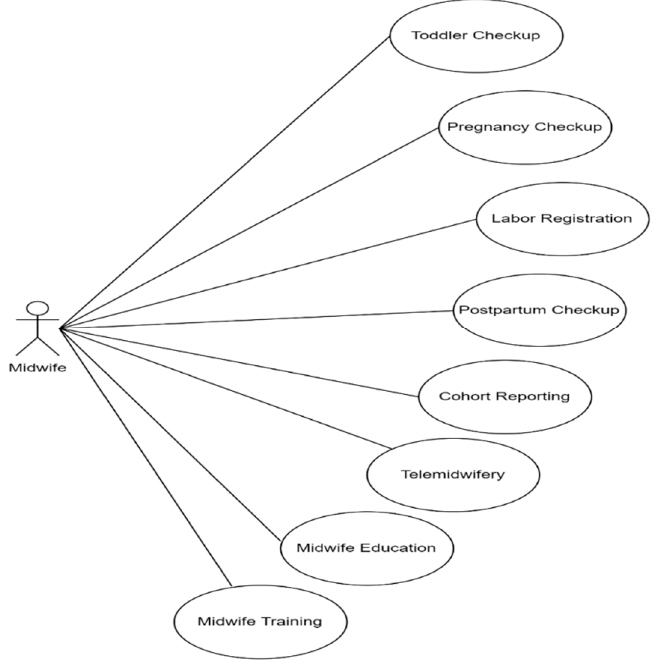
Figure 4. Diagram use case midwife ( bidan